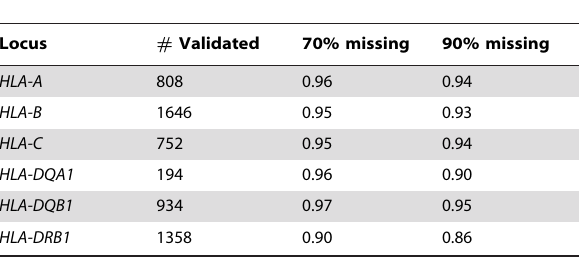
Table 4. Missing data in the inference